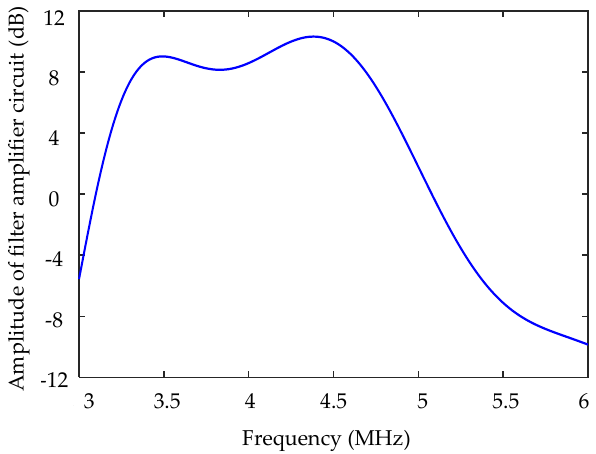
Figure 14. Magnitude-frequency characteristic of filter amplifier circuit.